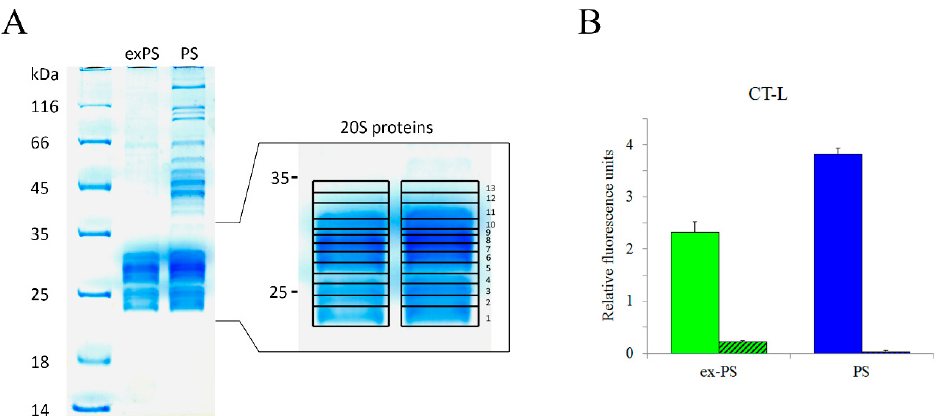
Figure 1. A ffi nity-purified extracellular and cellular proteasomes from conditioned medium (CM) and β 7-HTBH K562 cells preserve chymotrypsin-like peptidase activity. ( A ) Proteins from a ffi nity-purified cellular (PS) and extracellular (ex-PS) proteasomes (10 µ g) were separated by SDS-PAGE and visualized with Coomassie Blue. Positions of 19S and 20S subcomplexes in the gel are shown. 20S proteasome proteins were cut into 13 pieces, which were then in-gel digested with trypsin. The peptide mixture was analyzed by matrix-assisted laser desorption / ionization Fourier transform ion cyclotron resonance mass spectrometry (MALDI FT-ICR MS). ( B ) Comparison of the purified intra- and extracellular proteasomes (1 µ g) for chymotrypsin-like (CT-L) activity in the presence or absence of proteasome inhibitor MG132, determined by fluorometric quantification of the substrate Suc-LLVY-AMC (N-Succinyl-Leu-Leu-Val-Tyr-7-amino-4-methylcoumarin), using 380 nm excitation / 440 nm emission, respectively. The results are presented in the Y-axis as relative fluorescence units. The control is Suc-LLVY-AMC background